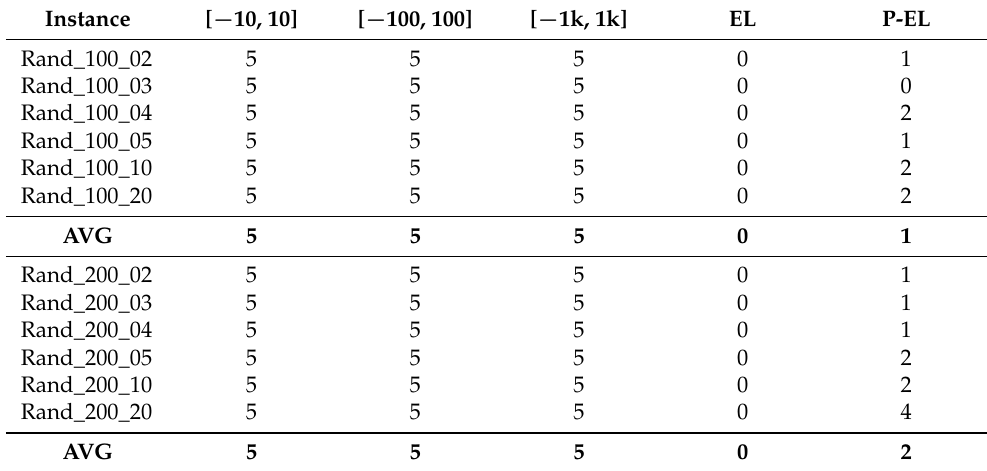
Table 5. Number of solutions with an objective function value equal to zero.